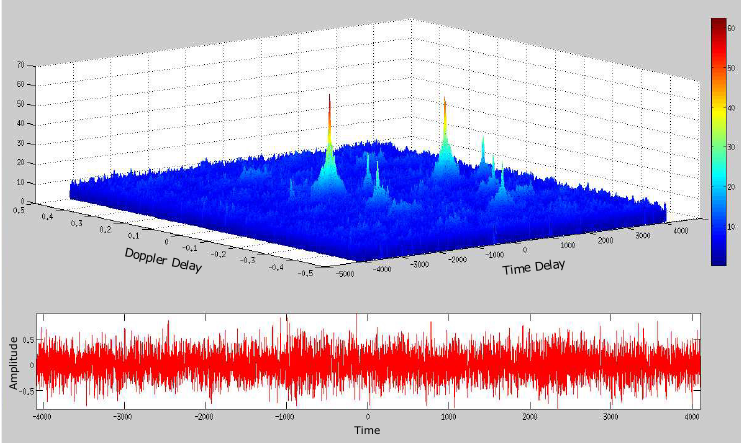
Figure 32. Multiple object tracking using MMPP “chirp pulses”, at Tracking Time 4, with − 5 dB SNR.